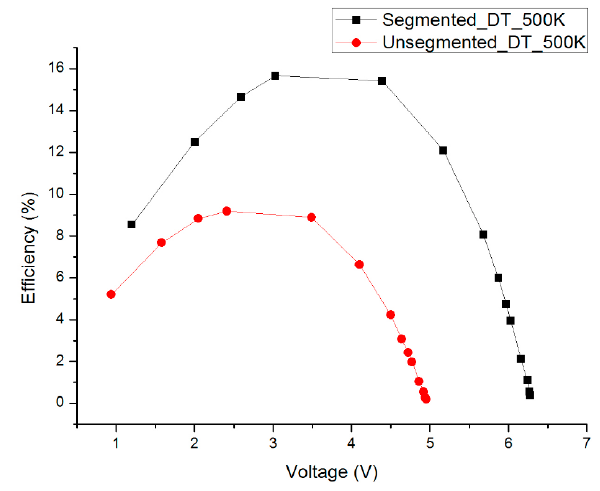
Figure 5. Comparison of the simulated efficiencies for the segmented module and the unsegmented module.